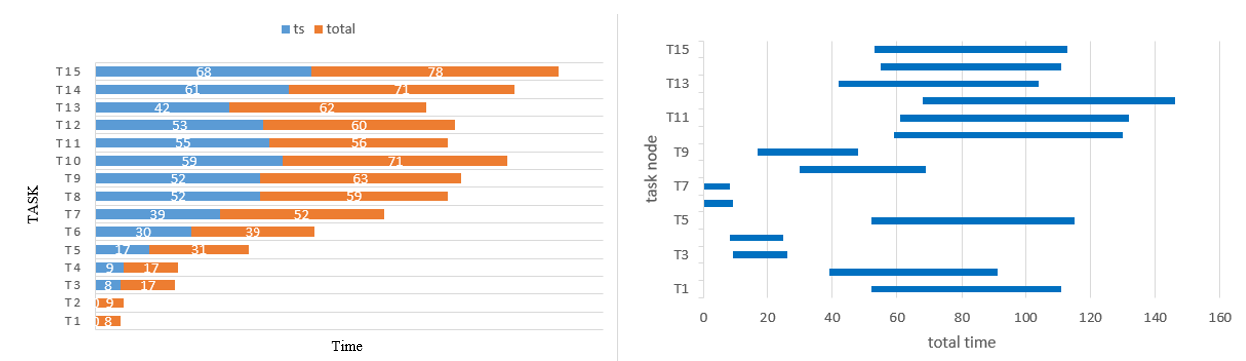
Figure 12. The Gantt of task